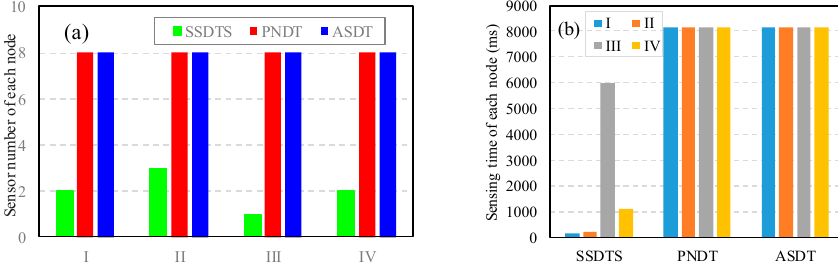
Figure 7. Sensor number and sensing time of each node. ( a ) Sensor number of each node for different events, ( b ) Sensing time of each node for different events.